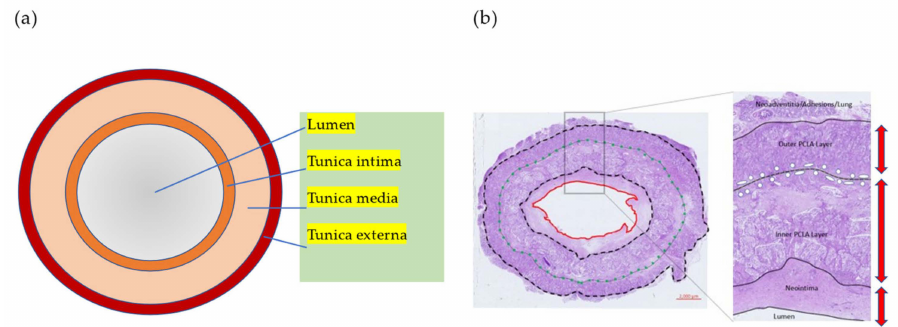
Figure 2. ( a ) Typical structure diagram of blood vessels. Blood vessels consist of three layers: tunica intima, tunica media, and tunica externa. ( b ) Tissue staining image of a typical TEVG fabricated with polylactide-co-caprolactone (PCLA) and polyglycolic acid (PGA) in sheep models. After only six weeks, TEVG has remodeled three layers like a native vessel structure. The image was produced by the authors using images from our previous study.